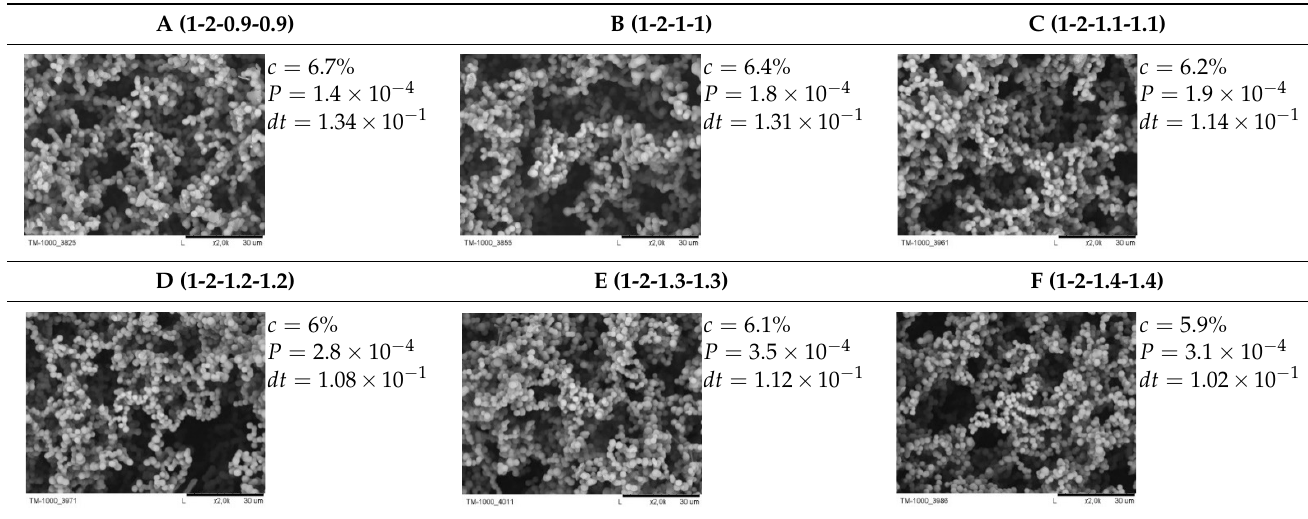
Table 1. Designated model parameters: secondary particle concentration ( c ), probability of an effective collision ( P ) and time step ( dt ) for actual experimental syntheses A–F.